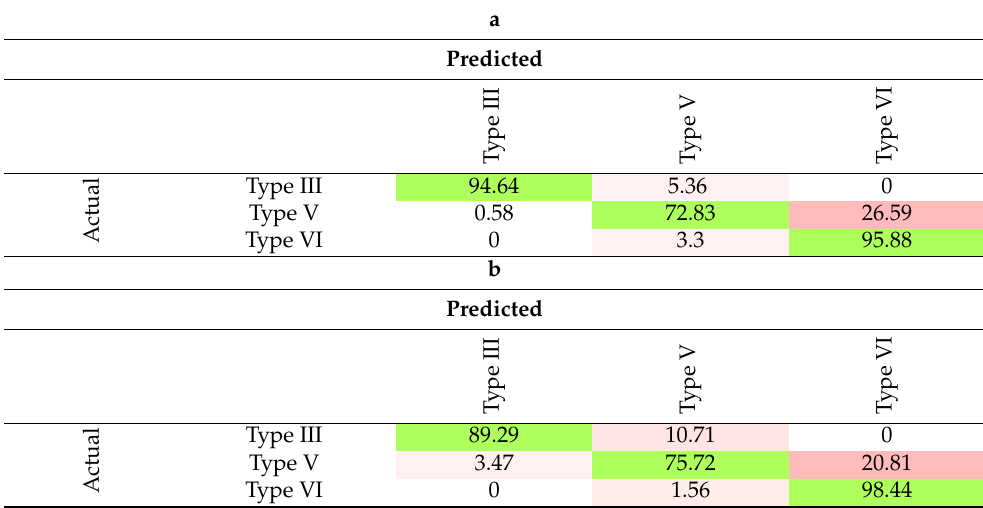
Table 4. Confusion matrix results for the single classifier in the ( a ) unique and ( b ) pipeline models.